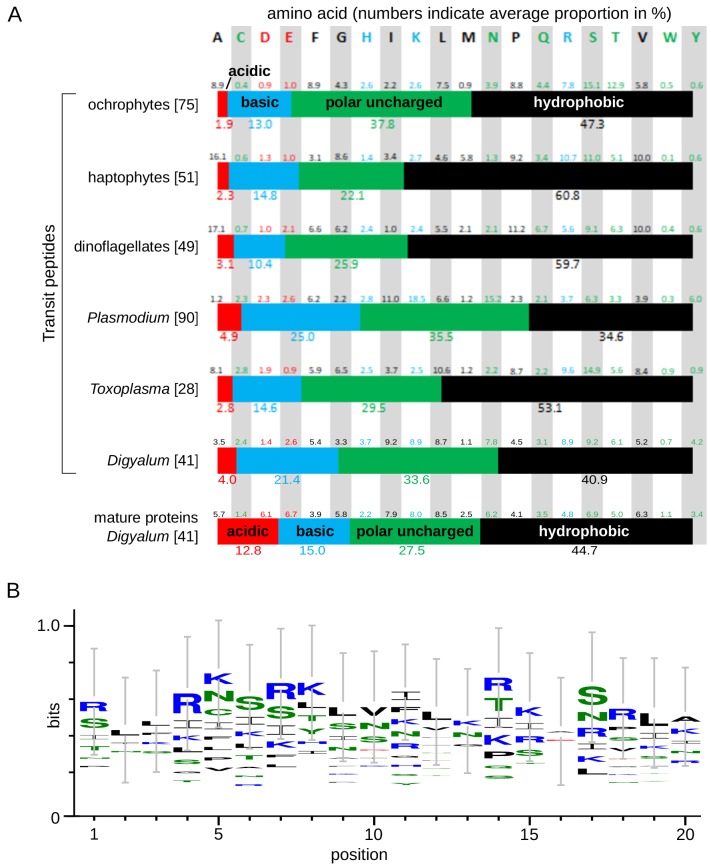
Transit peptides in Digyalum plastid proteins have positive charge but lack a conserved phenylalanine in the first position.(A) Amino acid composition of plastid transit peptides in Digyalum in comparison with downstream sequences of mature plastid proteins and transit peptides in other complex plastids as reported by Patron and Waller (2007) (only the first 14 residues were analyzed to enable consistent comparison) (Patron and Waller, 2007). Average proportions of individual amino acids and their classes based on charge (colored bars) are shown: acidic (D + E) in red, basic (H + K + R) in blue, polar uncharged (C + N + Q + S + T + W + Y) in green and hydrophobic (A + F + G + I + L + M + P + V) in black. Number of proteins analyzed are indicated in square brackets behind species/group names. (B) WebLogo3 diagram of the relative composition of the first 20 amino acids in 41 target peptides of Digyalum oweni. Letter size indicates the probability of an amino acid occurring at a specific position, weighted to account for the relative abundance of each amino acids natural occurrence and unrepresentative results arising from a small sample size.